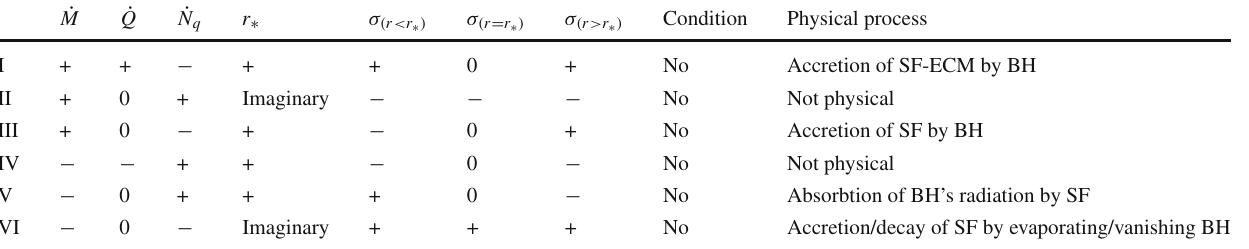
Table 5 General Bonnor–Vaidya BH and its quintessence SF parameters for (cid:2) = − 1